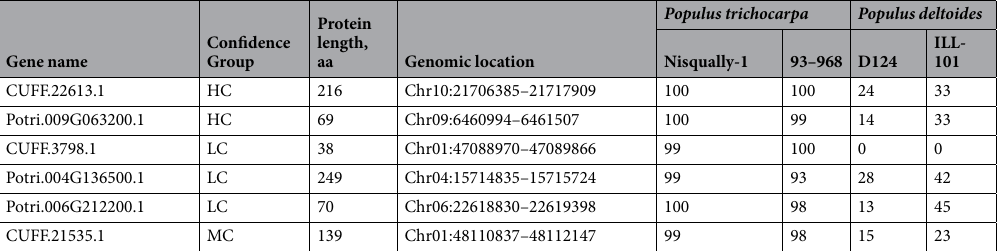
Table 1. SSP genes that have re-sequencing read coverage of > 90% in Populus trichocarpa (“93–968” and “Nisqually-1”) and < 50% in P. deltoides (“D124” and “ILL-101”). Confidence levels HC, MC and LC represent three computationally-predicted SSP sets: the high confidence set (“SSP_hc set”), the medium confidence set (“SSP_mc set”) and the low confidence set (“SSP_lc set”), respectively.